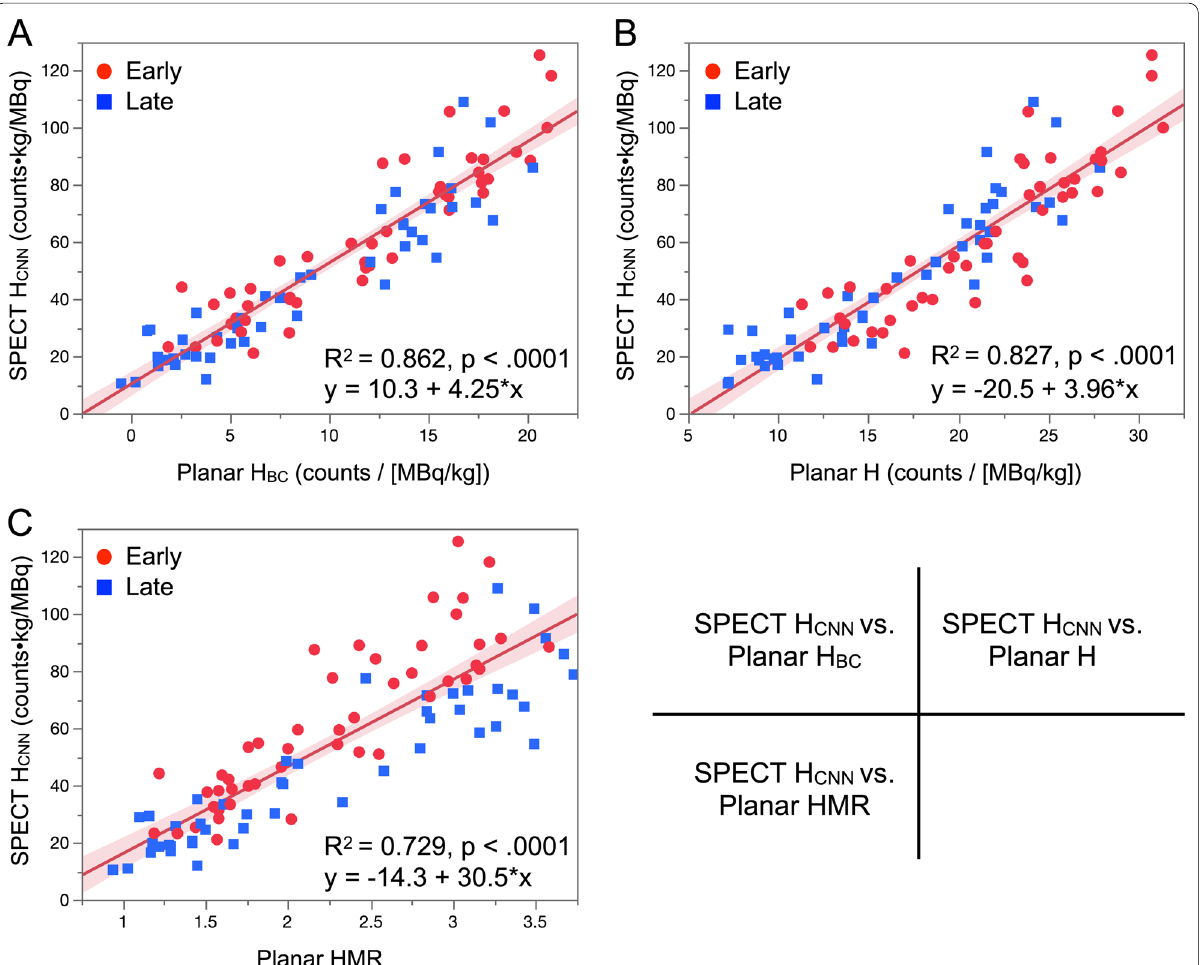
Fig. 3 Relationship of average heart counts calculated from SPECT images using CNN and from conventional early and late planar images. SPECT H CNN vs. planar H BC ( A ), planar H ( B ), and planar HMR ( C ). Red circles and blue squares, early and late images, respectively. Shaded area, confidence of